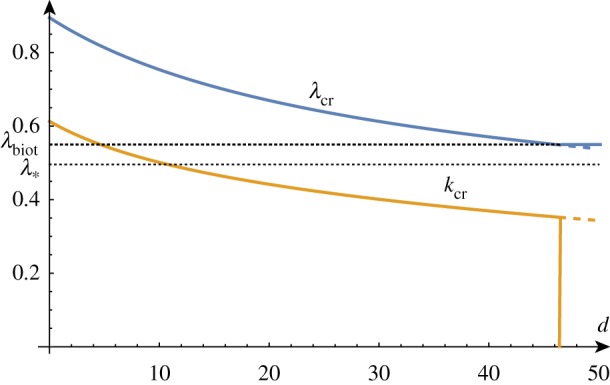
kcr and λcr as functions of d for β = 10. (Online version in colour.)